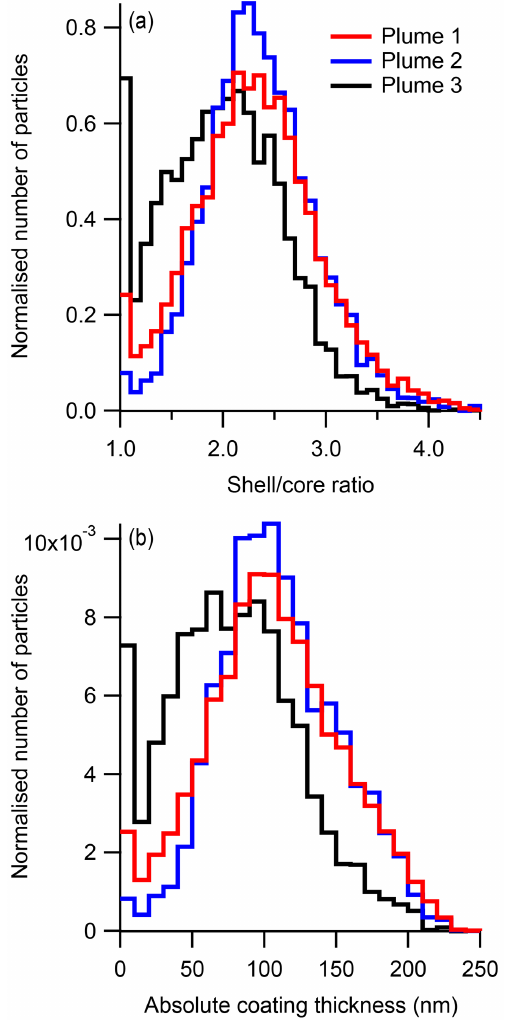
Figure 6. Distributions of coating thicknesses, measured by the SP2, expressed in terms of (a) shell/core ratio and (b) absolute coating thickness. The first bin ( D P = D C = 1, uncoated particle) also contains all particles with measured scattering less than that predicted for an uncoated core (equivalent to D P <D C ). Such par- ticles are a result of random variations in the detected scattering; however as the result D P <D C is nonphysical, they are assigned the nearest realistic value.